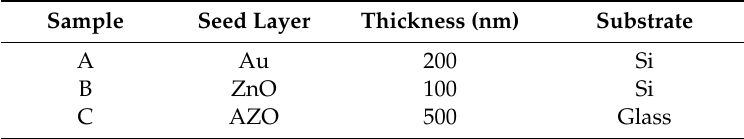
Table 1. Overview of the seed layers under study and their